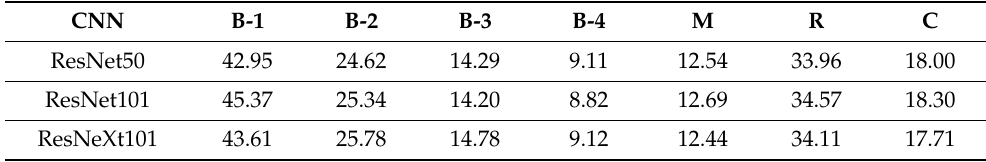
Table 5. Performance on test splits for RDNpos